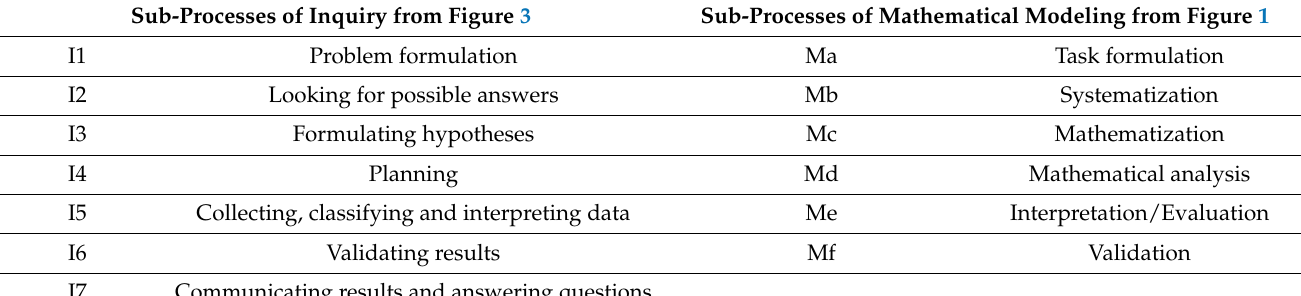
Table 1. List of sub-processes of inquiry and of mathematical